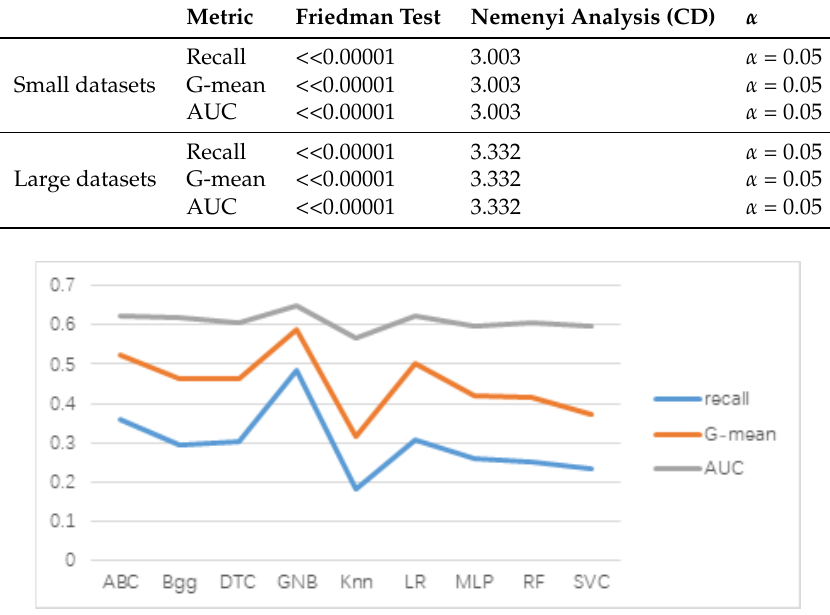
Figure 5. Average result value of 3 metrics for 9